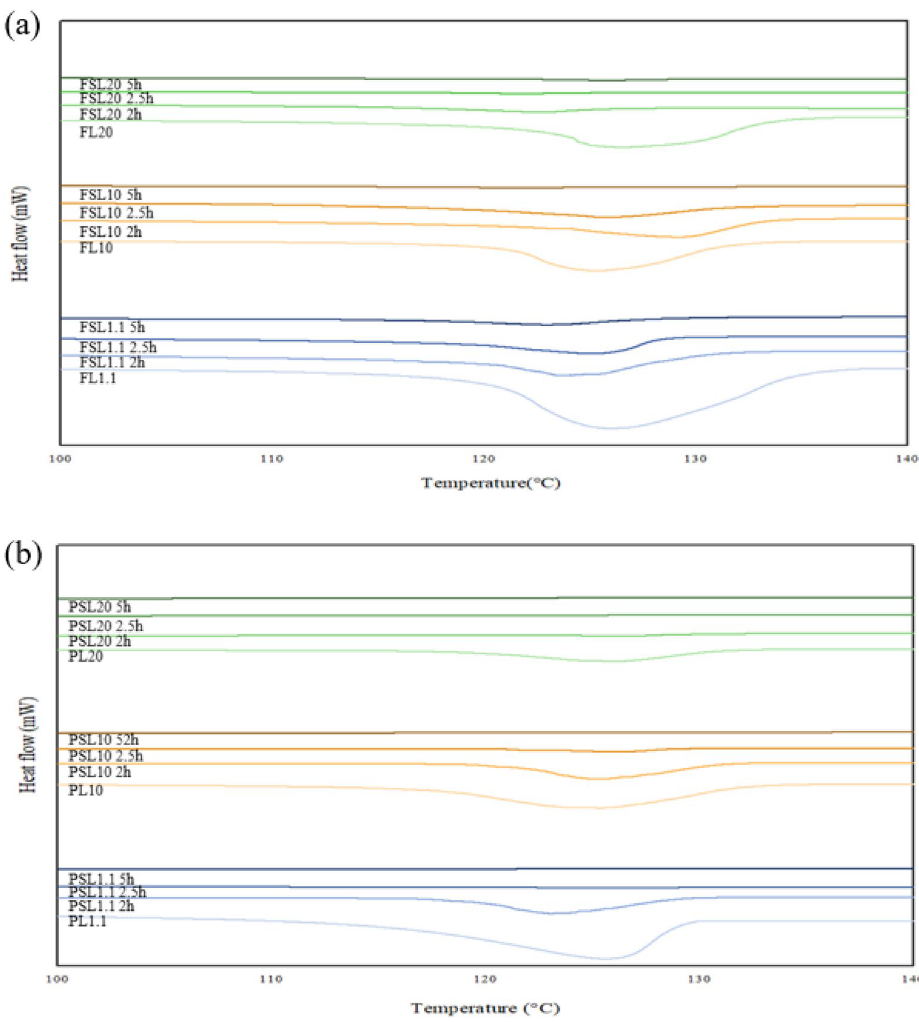
Figure 7. DSC curves of the LLDPE fibers with melt flow index of 1.1, 10, and 20 according to the sulfonation time under a pressure of 5 bar and temperature of 130 °C ( a ) Fully drawn sulfonated LLDPE fiber, ( b ) Partially drawn sulfonated LLDPE